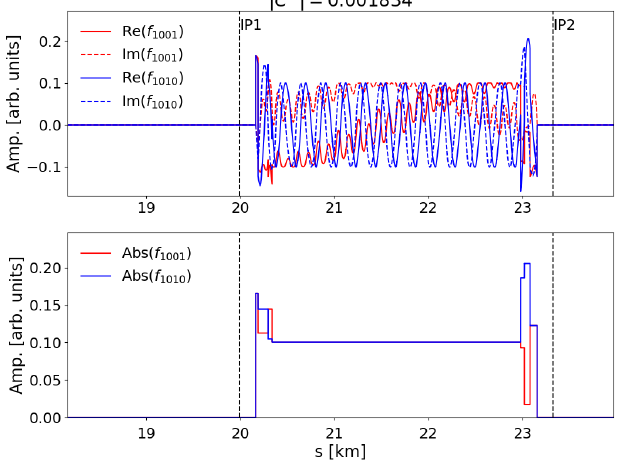
FIG. 14. Top: Real (solid) and imaginary (dashed) components for the coupling RDTs f 1001 (red) and f 1010 (blue) focused on Sector 12. Bottom: The absolute value of the RDT ’ s in the same location. It can be seen that there is no coupling outside of this region, while maintaining strong coupling inside this region.